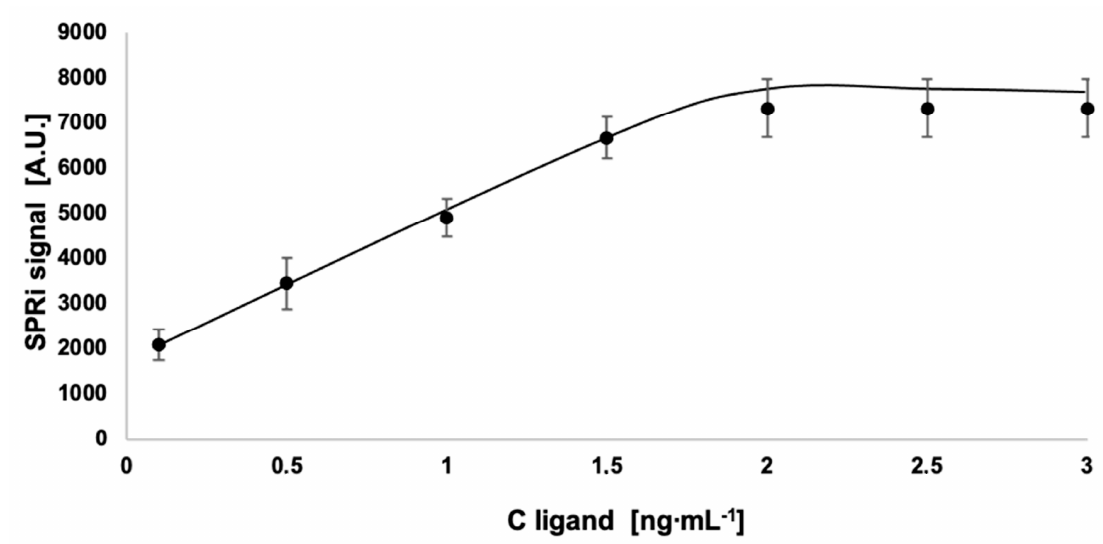
Figure A5. Surface saturation curves. Concentration of PARP-1 protein = 5 ng · mL − 1 , pH = 7.4.